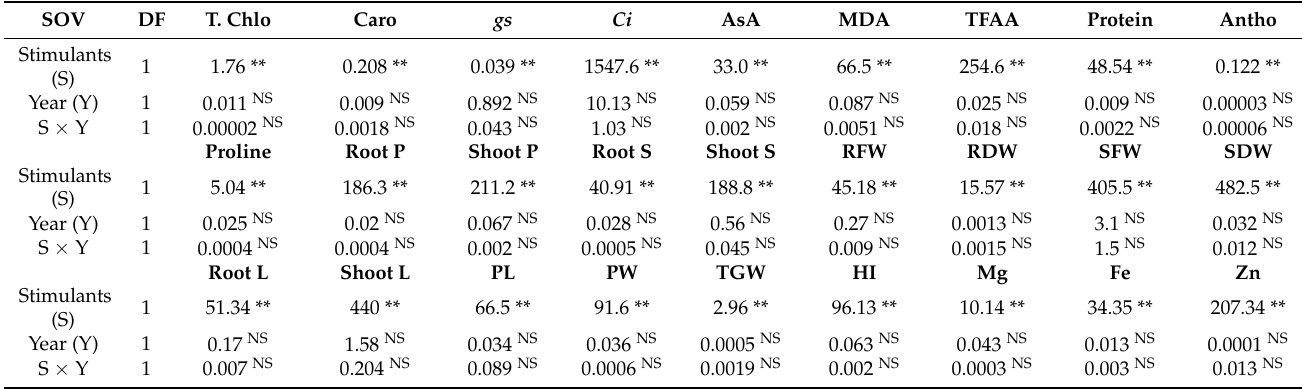
Table 1. Mean sum of squares of growth, physiological and yield parameters of quinoa in response to foliar applied plant growth promoters.